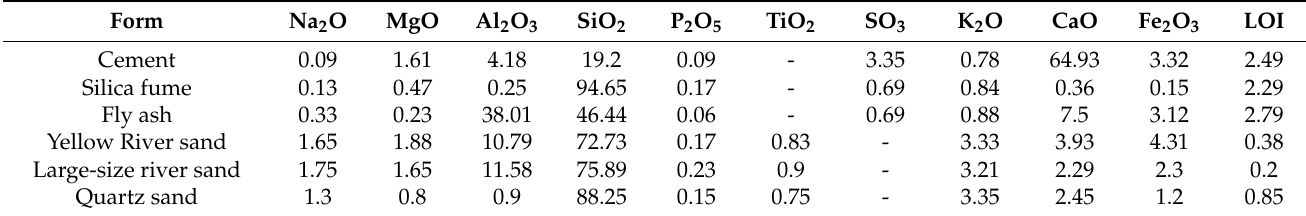
Table 1. Raw material